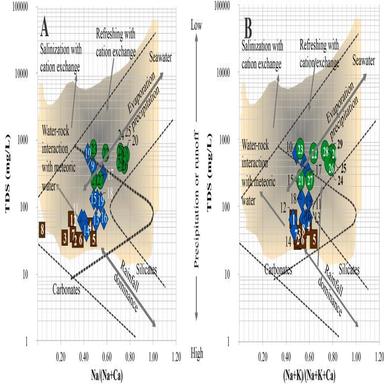
Extended Gibbs diagrams for interpreting rock dilution processes for evolution of groundwater system that caused hydrochemistry of the water samples. Weathering of minerals by fluids induced different ranges of total dissolved solids (TDS), which suggests that the original minerals were (A) carbonates for the river and cold springs (owing to the low TDS and Na/(Na+Ca) ratio) and (B) silicates or carbonates for most hot spring samples (owing to the high TDS and (Na+K)/(Na+K+Ca) ratio). The shade